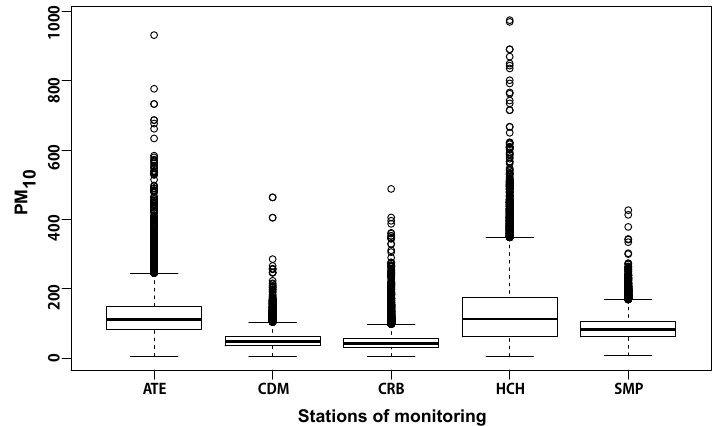
Figure 4. Boxplots for PM 10 in each